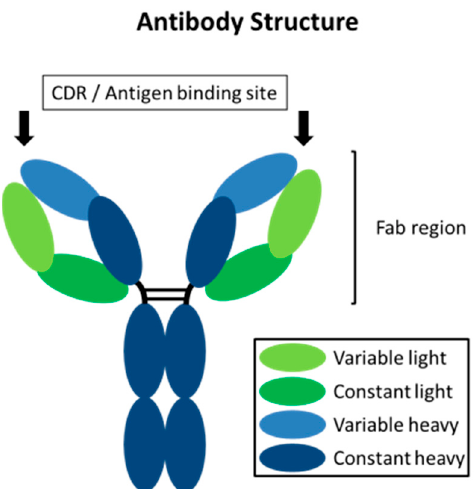
Figure 1. Schematic representation of an antibody with the heavy and light chains and the antigen binding site, with the complementarity-determining regions (CDRs) within the Fab region.